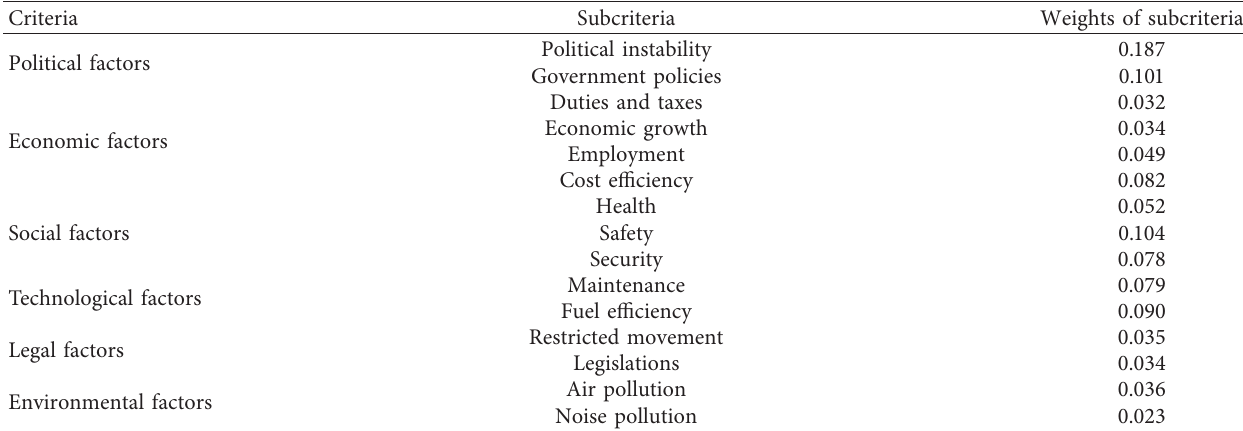
Table 4: Relative weights of the subfactors.